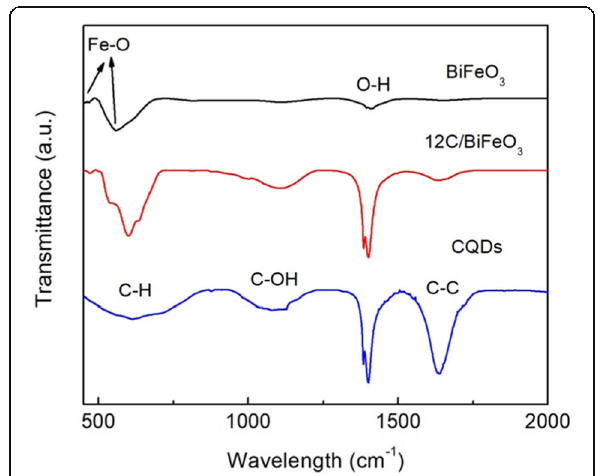
Fig. 3 FTIR spectra of BiFeO 3 , CQD, and the 12C/BFO